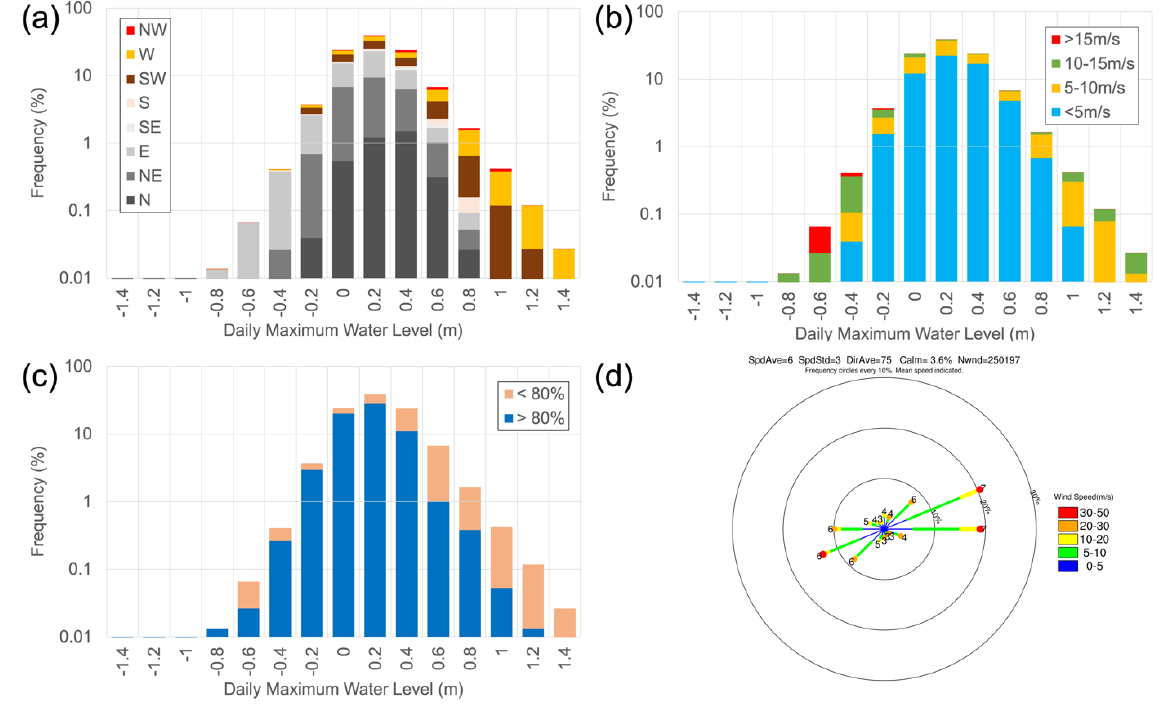
Figure 3. Histograms of the historical frequency of daily maximum water level subdivided by the associated ( a ) daily mean wind direction; ( b ) daily mean wind speed; and ( c ) daily mean sea ice concentration. The y -axis is on a logarithmic scale to highlight the extreme tails of the distribution. Windrose of the frequency of hourly station wind speed and direction from the Deadhorse Airport for 1979 – 2009 is shown in ( d ).